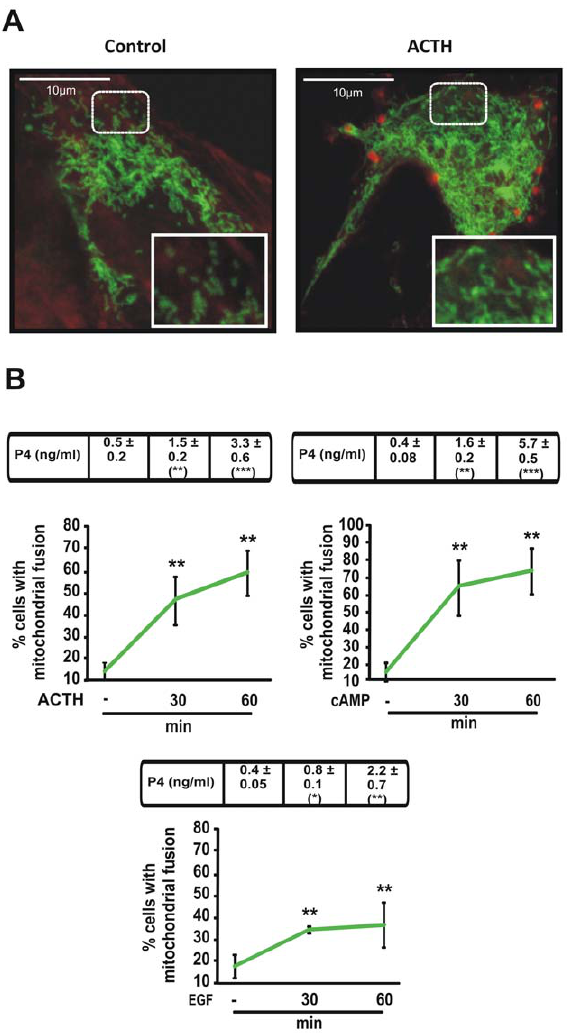
Figure 2. Hormonal stimulation causes an increase in fused mitochondria morphology in Y1 cells. A. Representative confocal images of Y1 cell line transfected with mtYFP. After 24 h transfection, cells were stimulated with or without ACTH (2 UI/ml) for 1 h. Cell morphology was visualized by actin red staining with the fluorescence dye Phalloidin–TRITC (1:2000), incubated for 1 h at room temperature. Scale bar, 10 m m. B. After 24 h transfection with mt-YFP, Y1 cells were treated with or without ACTH (2 UI/ml), 8Br-cAMP (1 mM) or EGF (10 ng/ml), at the indicated times. See comments in Figure 1. Results of P4 measurement are indicated at the top of each graph as the means 6 SEM of three independent experiments. * P , 0.05 vs. control. *** P , 0.001 vs. control. ** P , 0.01 vs. control.